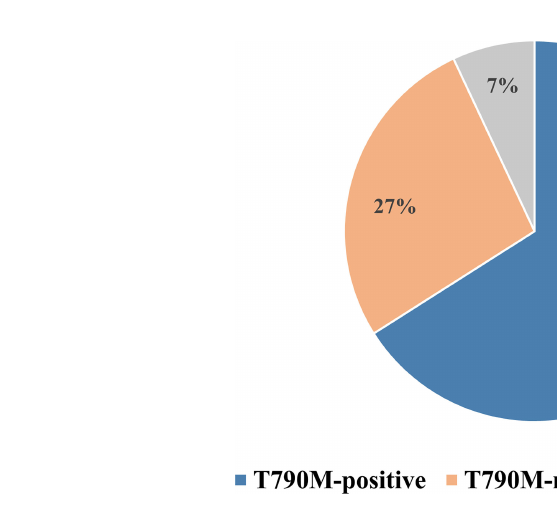
FIGURE 2 | Percentages of T790M-positive, T790M-negative, and T790M-unknown patients in enrolled